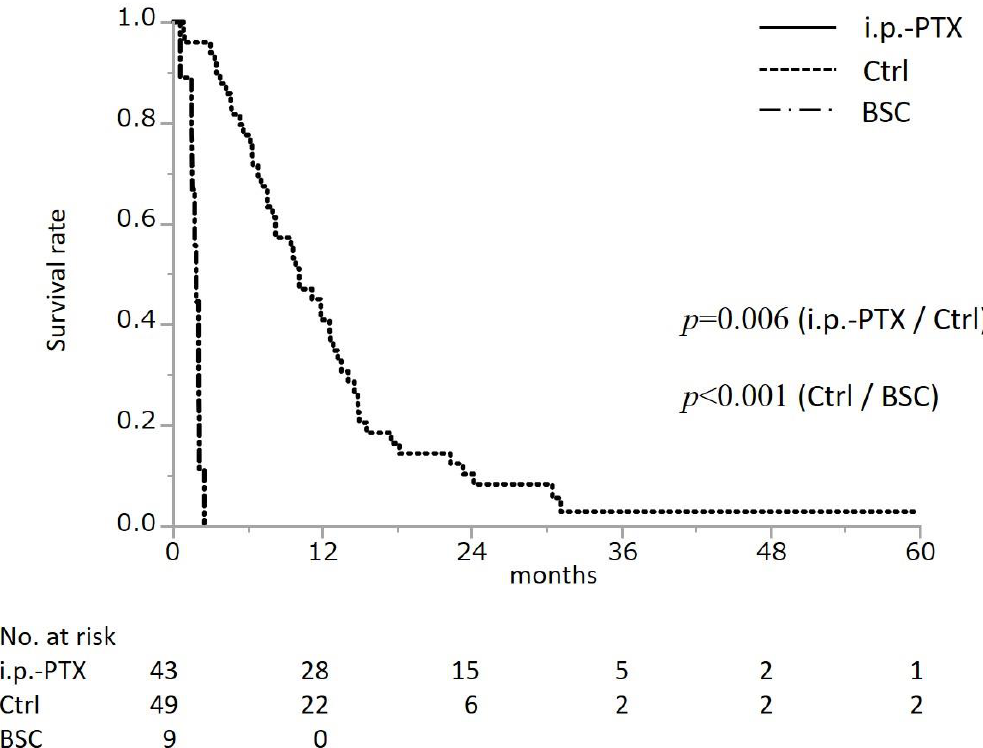
Figure 2. Overall survival following initial treatment. i.p.-PTX, intraperitoneal paclitaxel; Ctrl, control; BSC, best supportive care. The p- value was calculated by log-rank test. The median survival time was 17.9 months in the i.p.-PTX group ( n = 43), 10.2 months in the Ctrl group ( n = 49), and 1.9 months in the BSC group ( n = 9). Univariate analysis revealed that i.p.-PTX, clinical response (complete response [CR]/partial response [PR] rate according to RECIST criteria), and conversion surgery were significantly associated with survival (Table 2). Multivariate analysis revealed that only CR/PR rates and conversion surgery were significant independent predictive factors. Table 2. Prognostic factors.